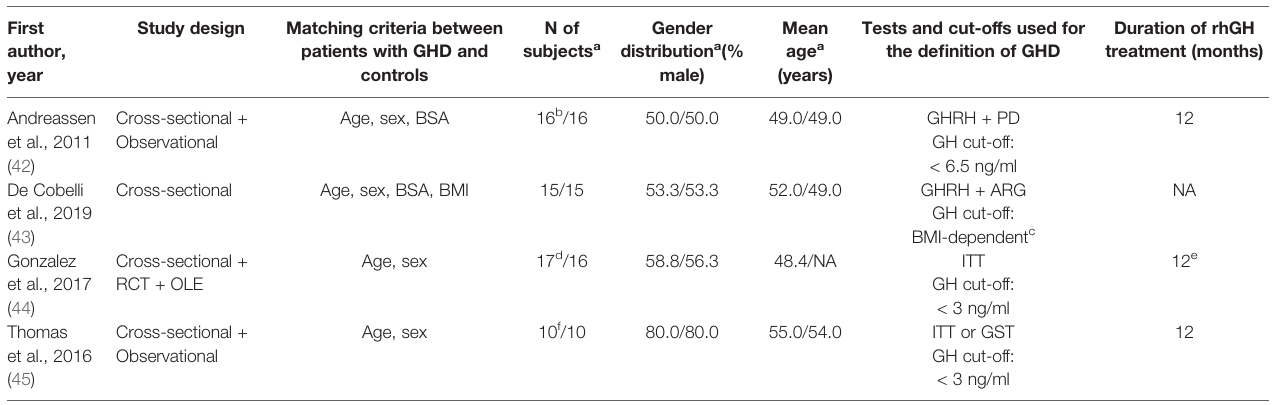
TABLE 1 | Study characteristics.